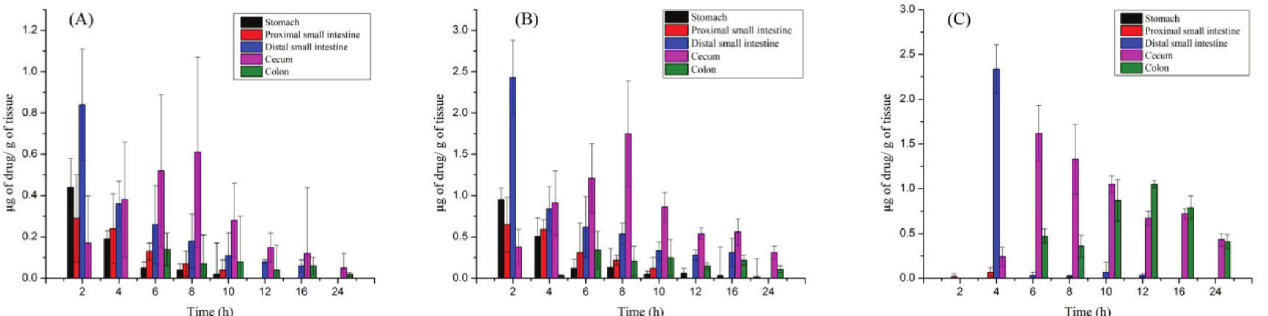
FIGURE 7 - Tacrolimus concentrations in different tissues after oral administration of (A) tacrolimus suspension, (B) tacrolimus- SDP, (C) tacrolimus-CSP. Data are presented as mean ± SD (n =